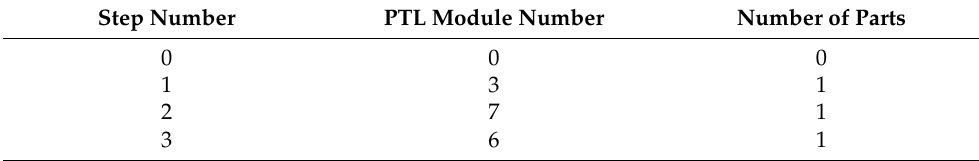
Table 2. Example of the content of an Excel